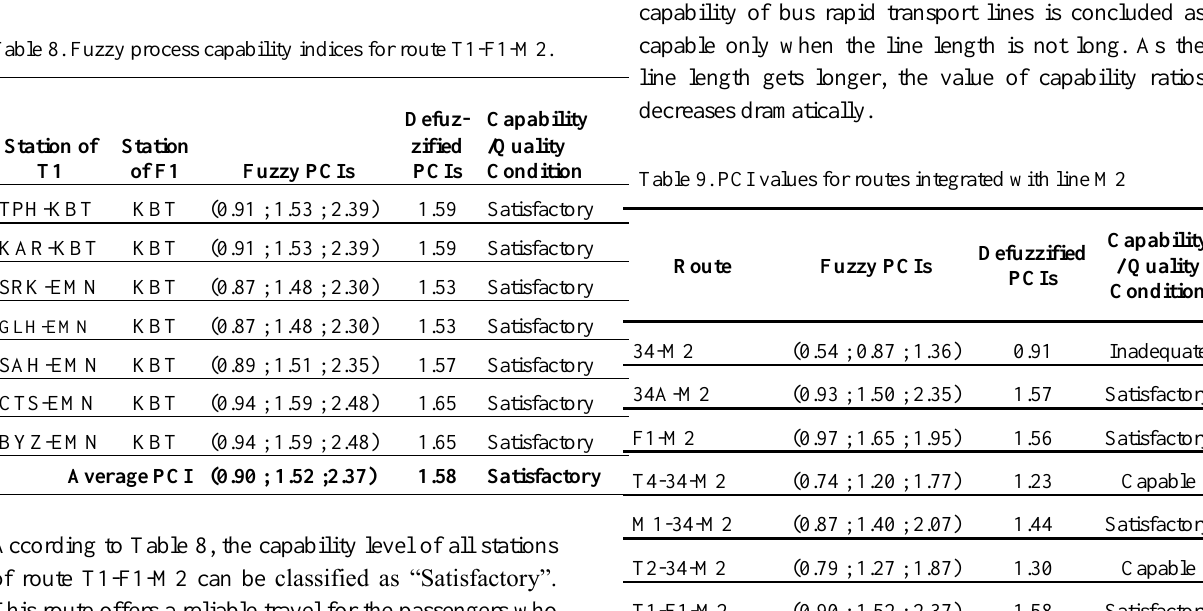
Table 8. Fuzzy process capability indices for route T1-F1-M2.